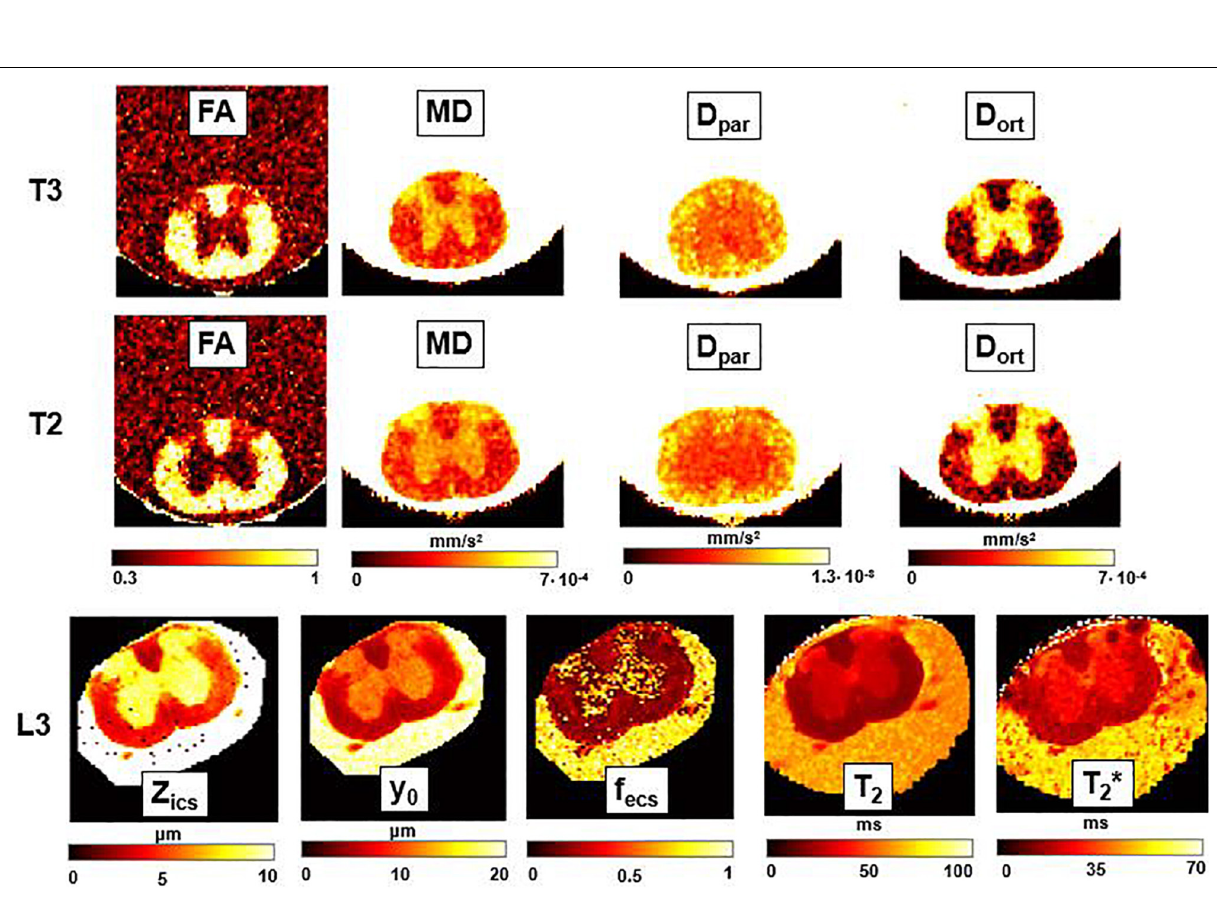
FIGURE 8 | DTI, T2-relaxometry and Q-space imaging. Parametric maps obtained from DTI (fractional anisotropy, FA; mean diffusivity, MD; longitudinal diffusivity, Dpar; radial diffusivity, Dort), Q-space imaging (Zics, representing the width of the intra-cellular space, y0, the FWHM of the Lorentzian, and f ecs , fraction of extracellular space) and T2 and T2* maps, for three axial slices corresponding, respectively, to the thoracic sections T3 and T2, and to the lumbar section L3. FA and f ecs are unitless, while for other parameters the unit of measurement is indicated near the